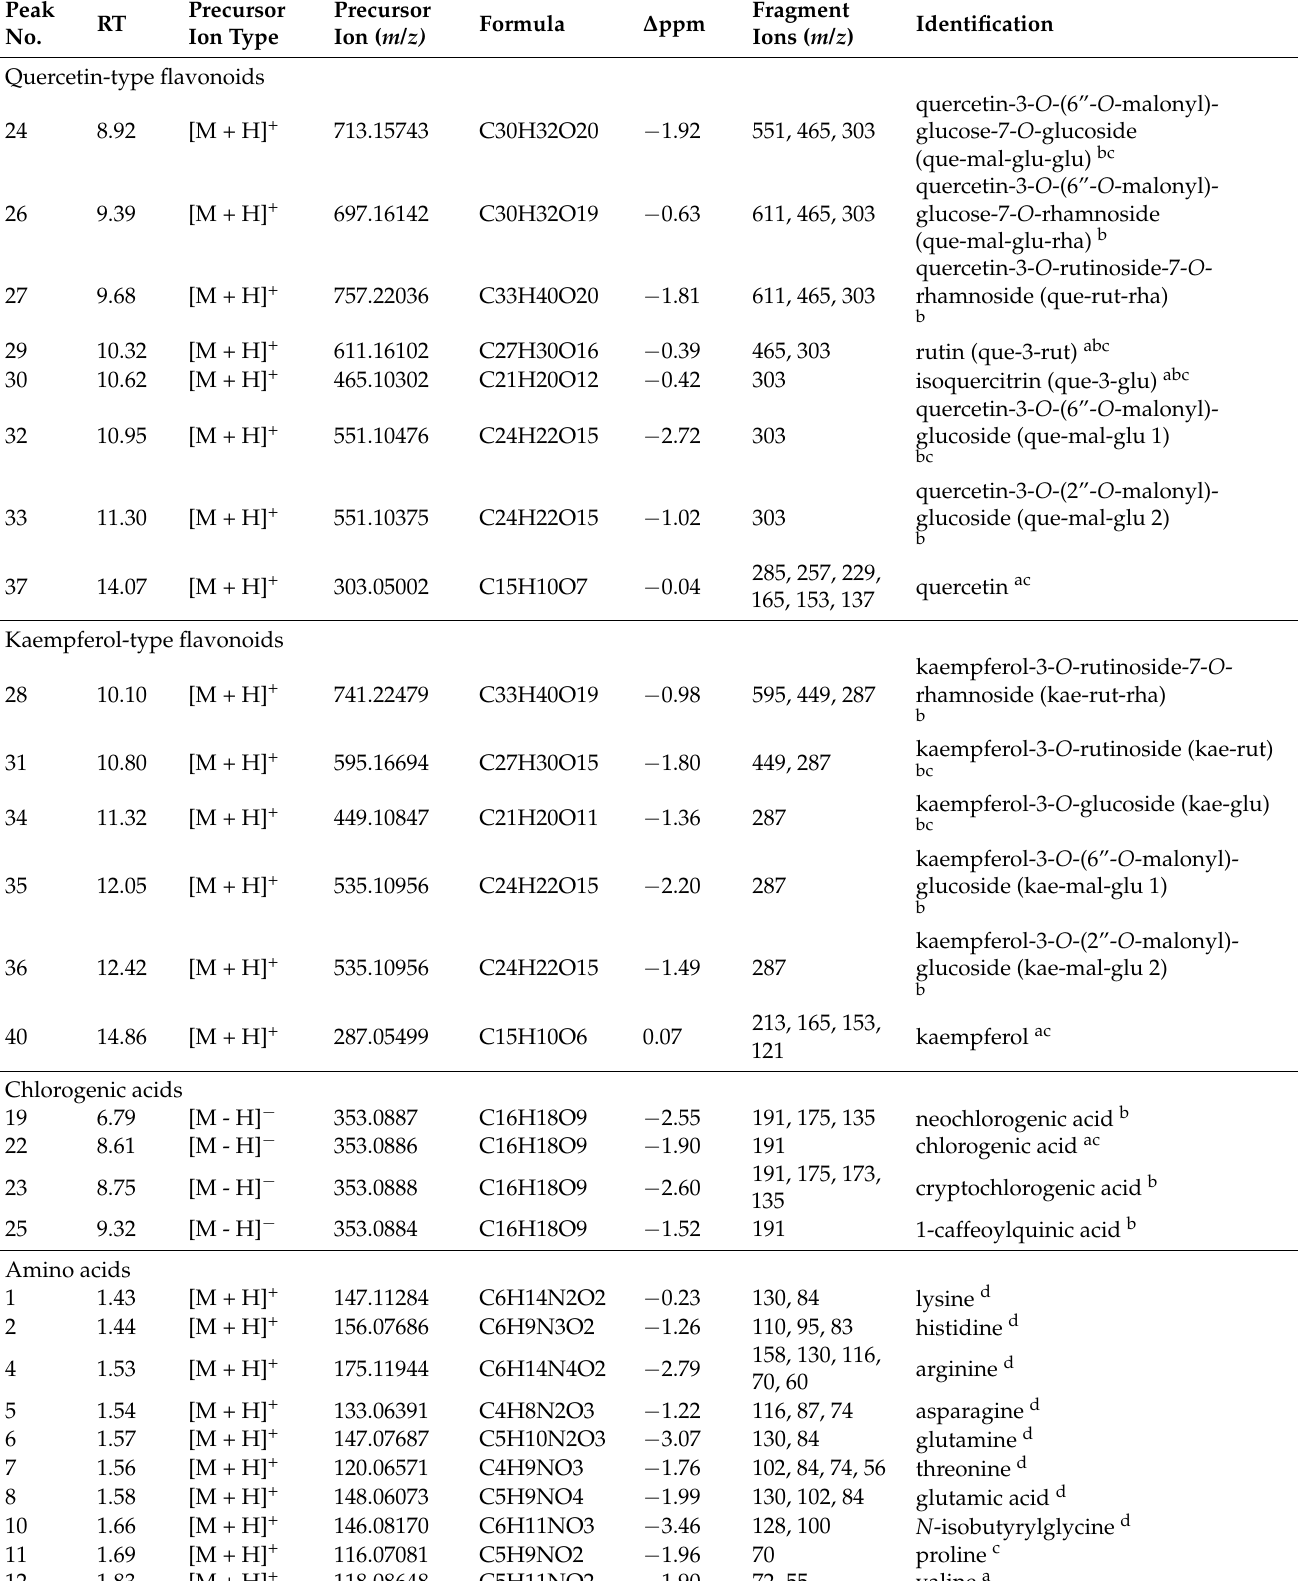
Table 1. Bioactive and nutritive compositions in 90 samples of Morus leaves under UHPLC-ESI- QTOF-MS/MS investigation in positive and negative ESI